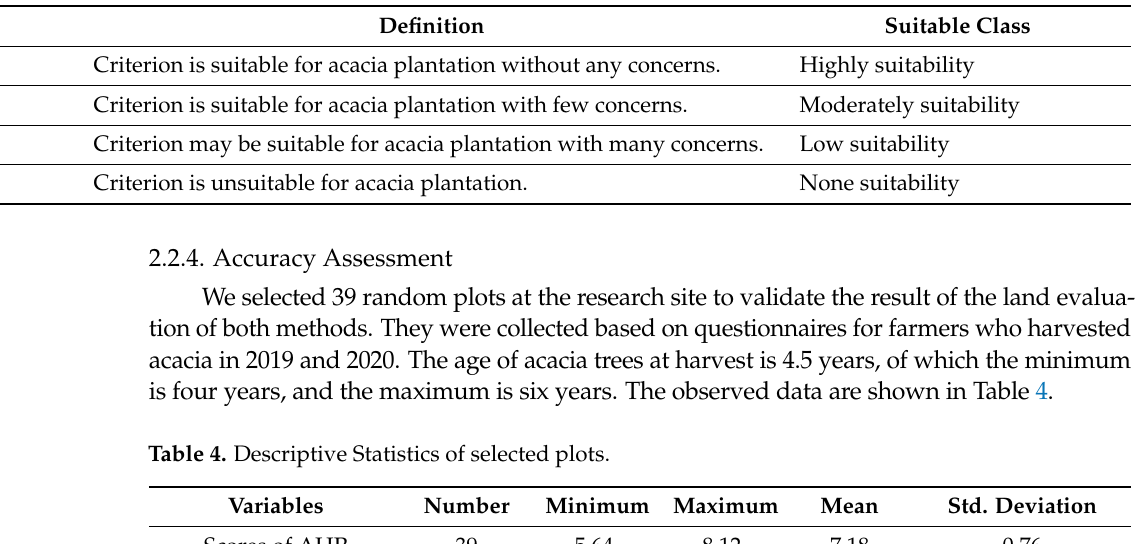
Table 3. Scale for scoring according to MCDA approaches.